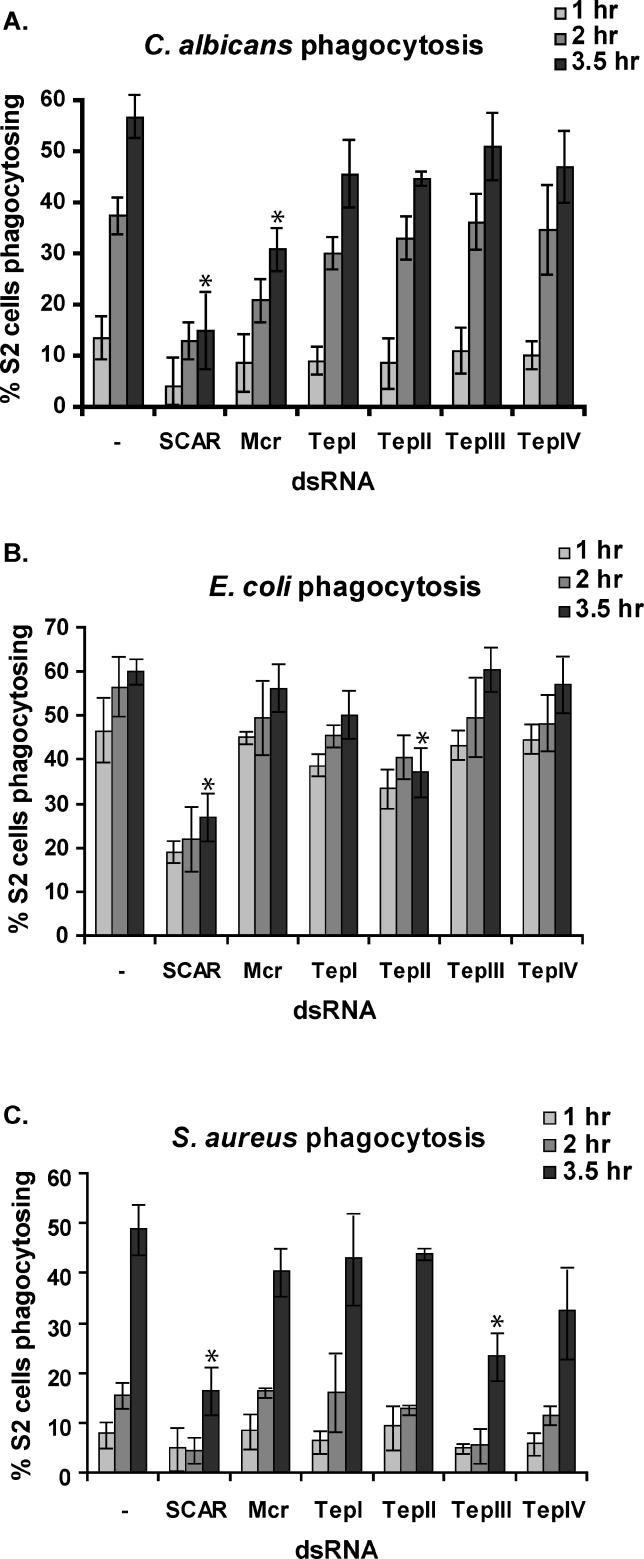
The Mcr/Tep Family of Proteins Determine Specificity of Pathogen Phagocytosis by Drosophila S2 Cells(A) S2 cells were treated with dsRNA against SCAR, Mcr, or one of the Drosophila Teps and co-incubated with C. albicans. The percentage of S2 cells phagocytosing one or more C. albicans was quantified and plotted.(B) The S2 cells treated above were also co-incubated with E. coli, and phagocytosis was quantified.(C) The RNAi-treated S2 cells above were co-incubated with S. aureus, and phagocytosis was quantified. In all graphs, the 3.5-h timepoints were analyzed using a t-test assuming unequal variance. Those values that differ significantly from untreated cells (p < 0.01) are indicated by asterisks.